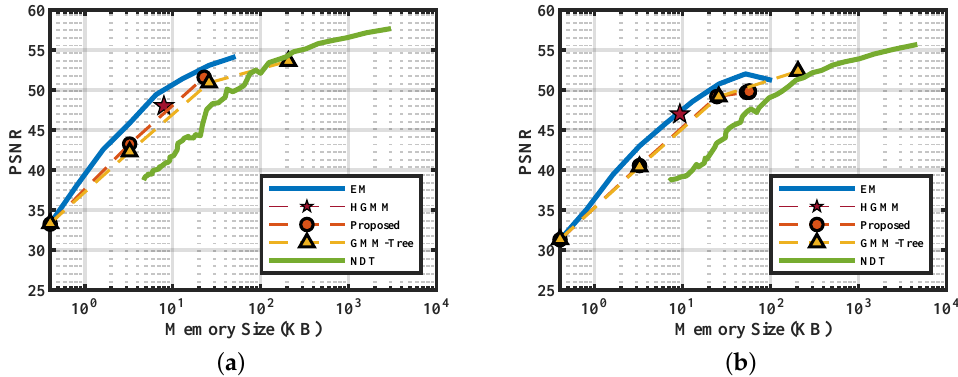
Figure 4. Peak Signal to Noise Ratio (PSNR) of the scenes selected from the RGB-D datasets. ( a ) Corner; ( b )